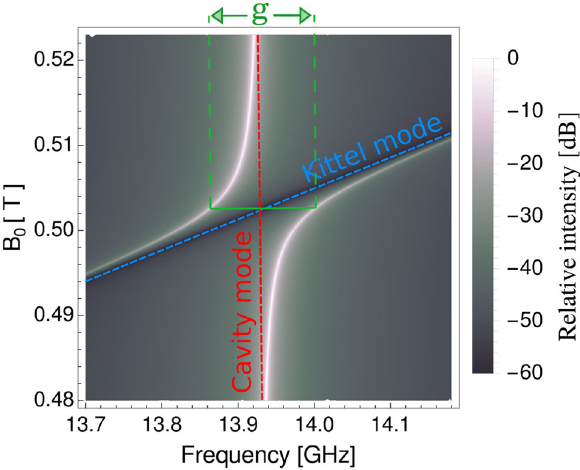
Fig. 1 Transmission spectrum of the hybrid system as a function of the external field B 0 , showing the anticrossing curve of the cavity mode (red dashed line) and Kittel mode (blue dashed line). The coupling g is defined by Eq.(5)